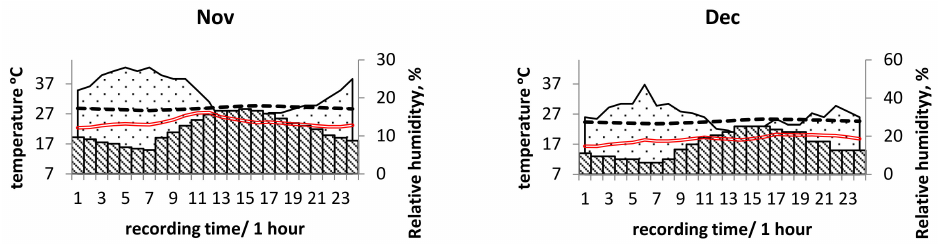
Figure 8. Indoor temperature and relative humidity of underground room and aboveground room, simulated using TAS EDSL for the whole year, where ORH is the outdoor relative humidity, OAT is the outdoor air temperature, UGR.IAT is the underground indoor temperature, and UGR.RH is the underground relative humidity.